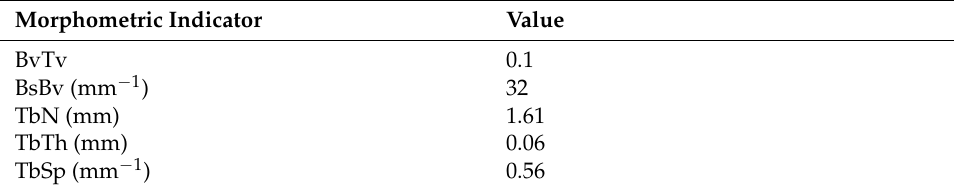
Table 5. The table shows the results of PyPored3D of the Morphometric Analysis on bone data. The total computation time was 0.3